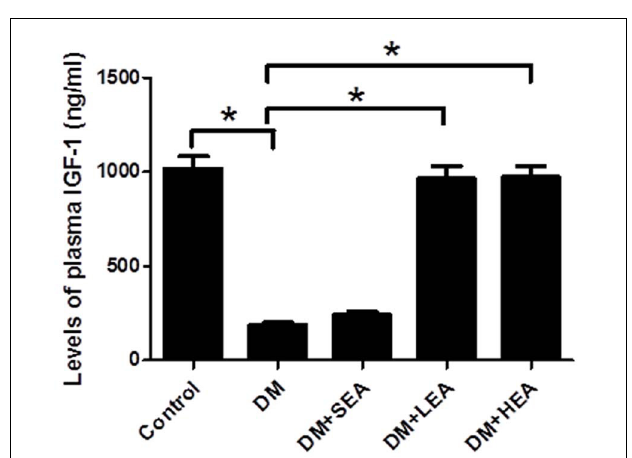
FIGURE 4 | The level of plasma insulin-like growth factor-1 (IGF-1) in each group. The IGF-1 level in the DM group was lower than that in the control group. However, the IGF-1 level in the DM + LEA and DM + HEA groups was elevated. One-way ANOVA was used to analyze the data, and the LSD post hoc test was used for the analyses. * P < 0.05 compared with the DM